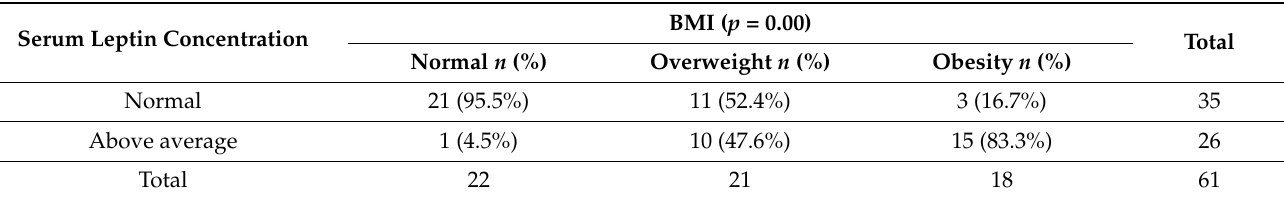
Figure 3. Spearman’s rank correlation between age and leptin concentration among patients in the study group (male: n = 39; female: n = 22). Table 3. Effect of overweight and obesity on leptin